Question: According to this chart, does the measure grow or shrink?
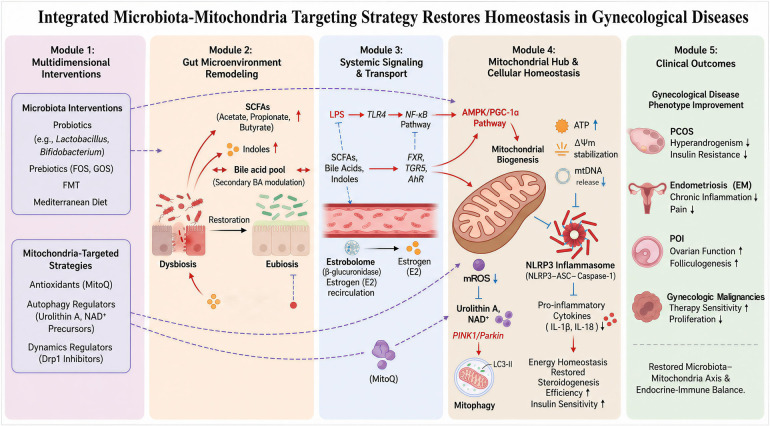
Answer: increasing